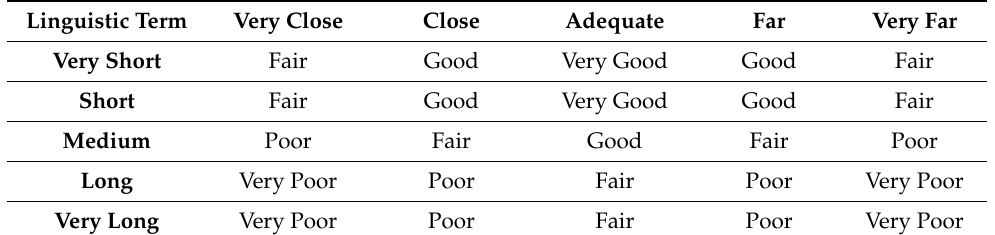
Table 2. Summary of rules used in the example for a 5-MF system. Linguistic